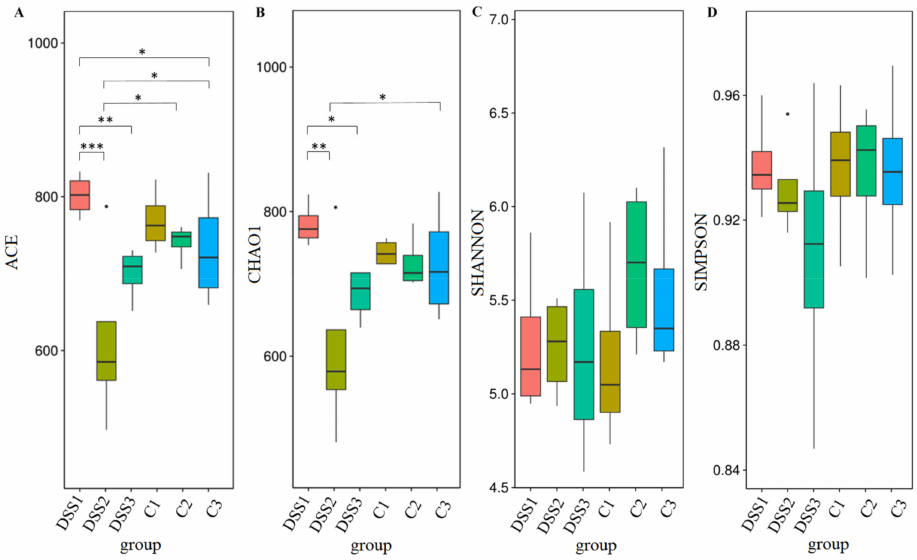
Figure 7. Boxplots of Alpha diversity indices. Numbers next to the group names represent time-points of faecal samples collection: 1, before induction of colitis (day 1); 2, at the end of DSS administration (day 7); 3, at the end of experiment (day 13). DSS, induced colitis; C, healthy control. Wilcoxon significance test: ACE diversity index ( A ): *** p < 0.001 for DSS1 vs DSS2, ** p < 0.01 for DSS1 vs DSS3; * p < 0.05 for DSS1 vs C3, DSS2 vs C2, DSS2 vs C3. Chao1 diversity index ( B ): ** p < 0.01 for DSS1 vs DSS2; * p < 0.05 for DSS1 vs DSS3, DSS2 vs C3. Shannon ( C ) and Simpson ( D ) diversity